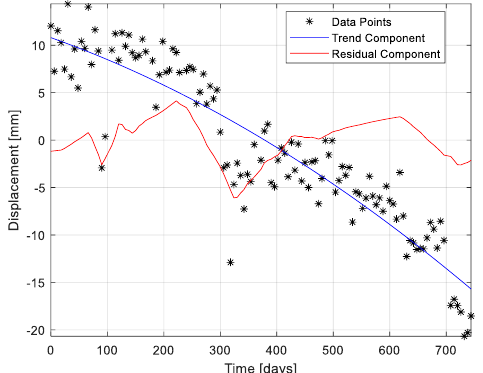
Figure 7. Displacement time series of PS 2(a) decomposed into a linear trend and cyclic component, (b) the estimated additive model.